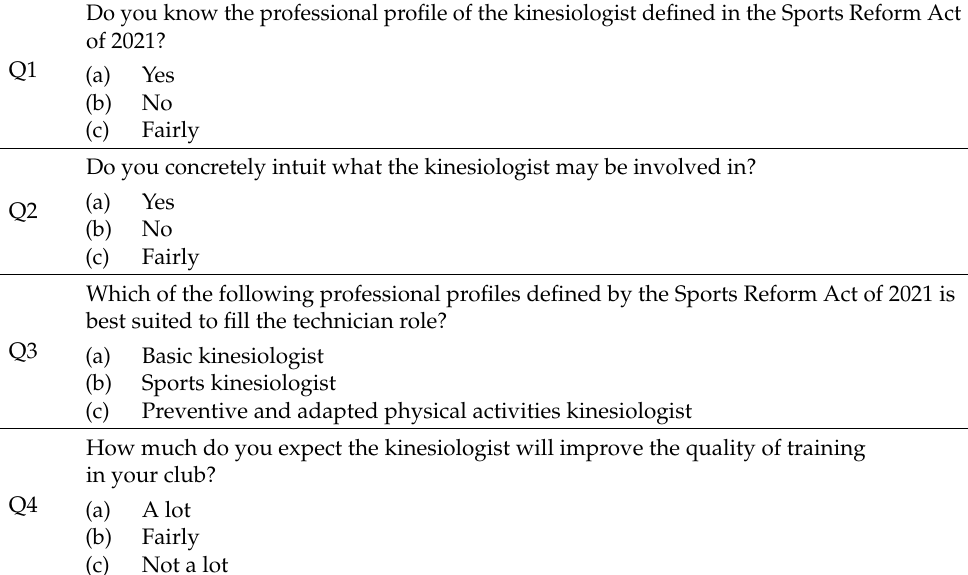
Table 1. Survey administered to the